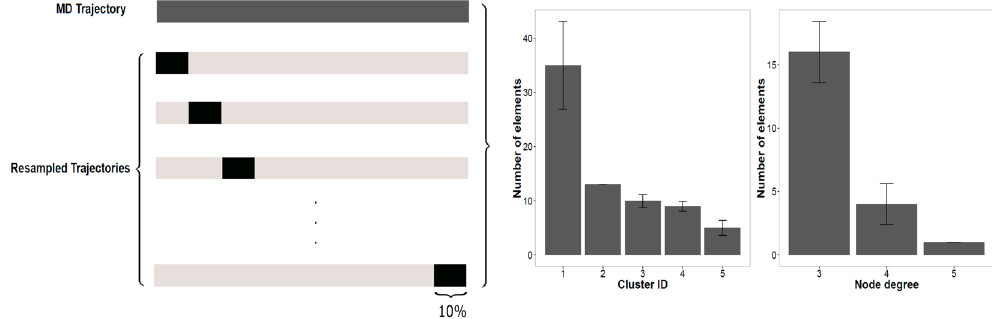
Figure 9. Jackknife resampling as implemented in PyInKnife . We show a schematic representation of the MD trajectory and the resampled trajectories used for the calculation of the convergence of PSN properties (left panel). The histograms show the two properties of the PSN analysis calculated for the whole trajectory, the connected components and the hubs (right panels). The example refers to the PSN analysis using a 5 Å distance cutoff of the CheY MD simulation with CHARMM22 * force field. Error bars represent the Jackknife standard error from the resampled